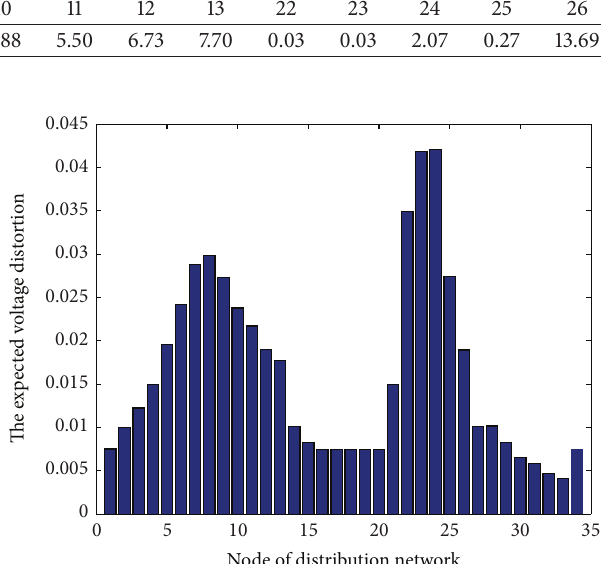
Figure 11: The probability distribution of voltage in node 26.